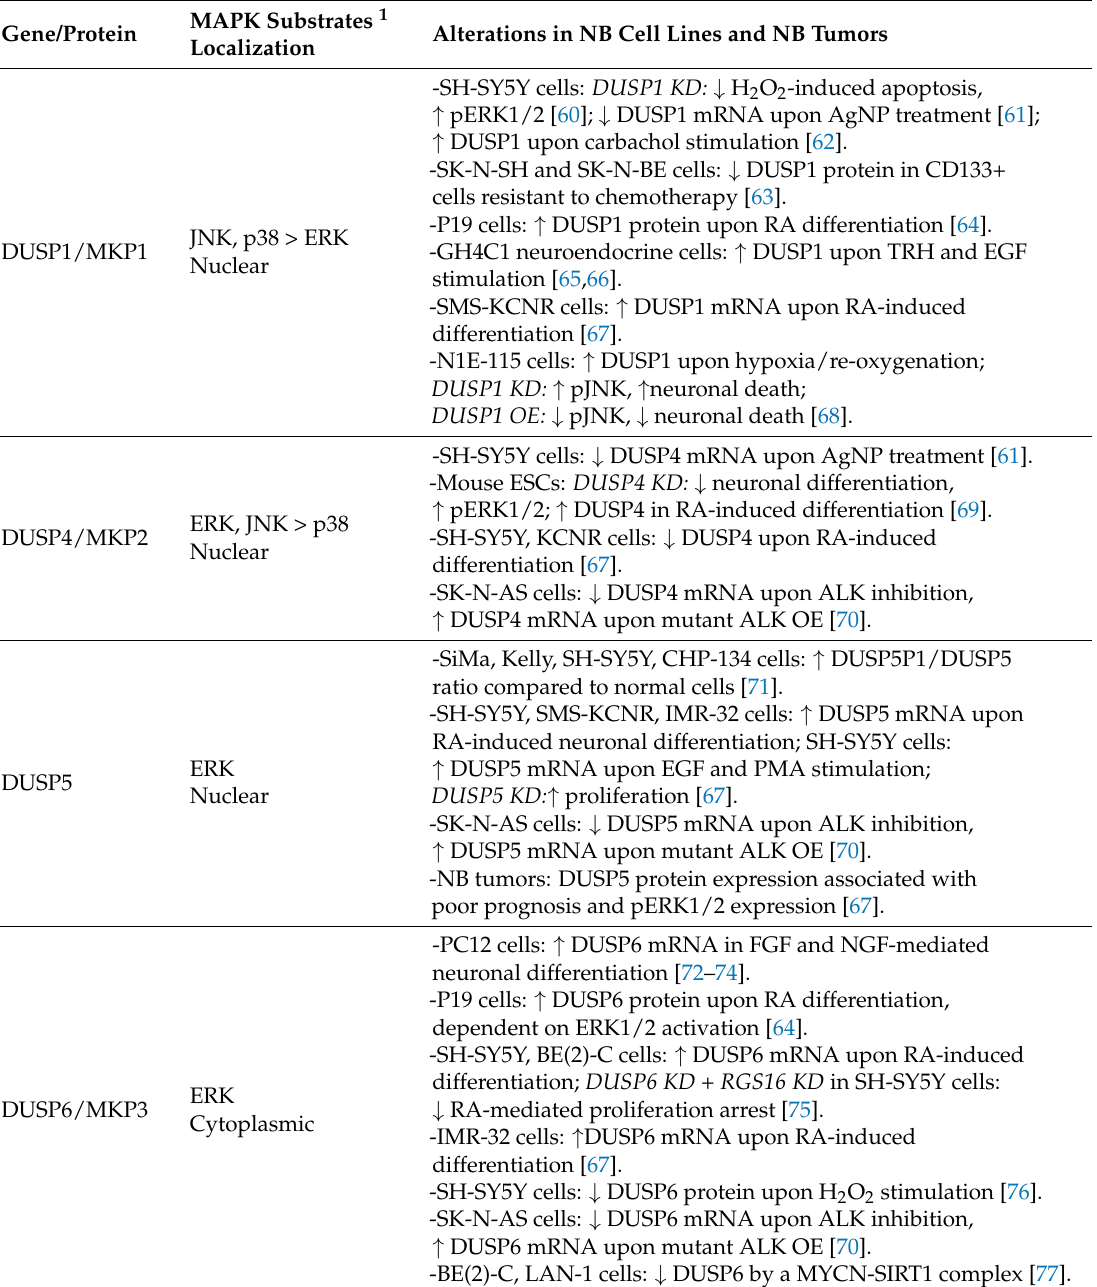
Table 1. MKPs and small-size atypical DUSPs in neuroblastoma cell growth and differentiation.